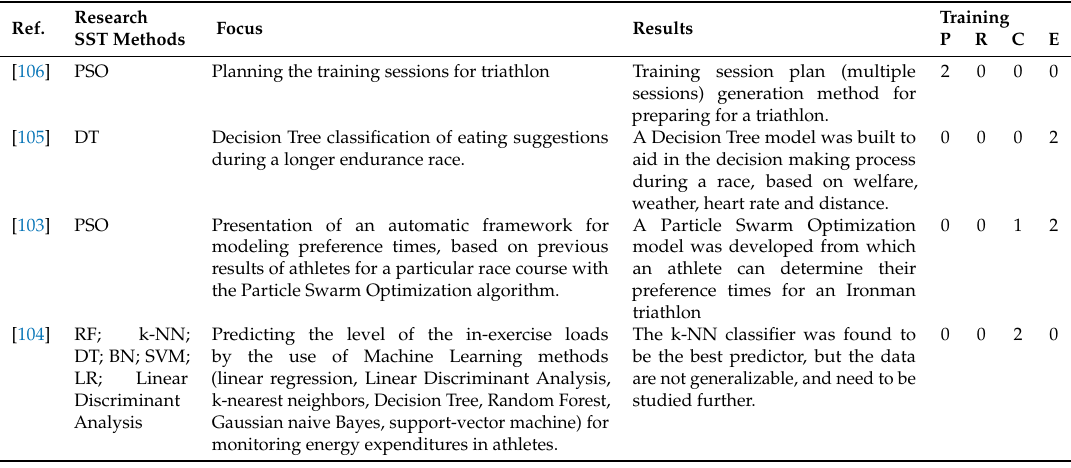
Table 15. Identified studies in the domain of